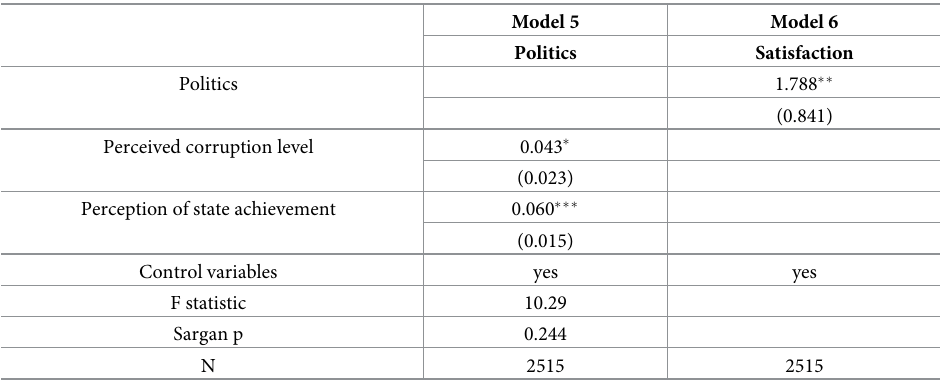
Table 3. Two-stage least squares regression